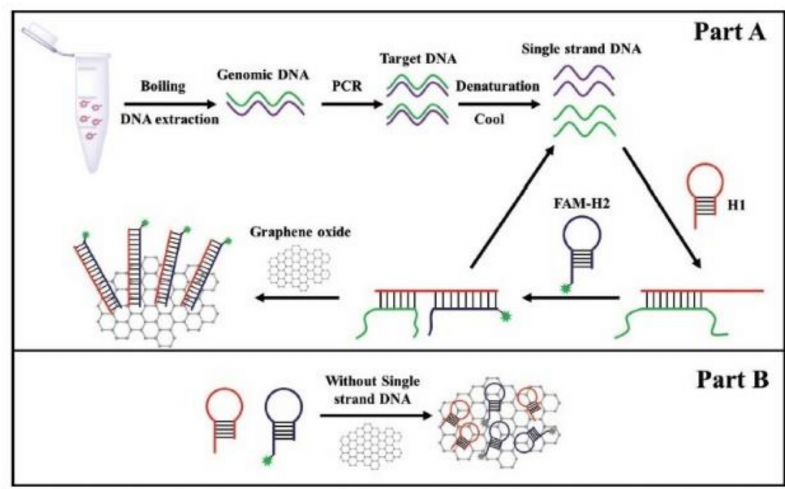
Figure 5. The principle of catalytic hairpin assembly-graphene oxide assay to detect emetic B. cereus in the presence of the target ssDNA ( A ) and in the negative control ( B ), (Adapted with permission from